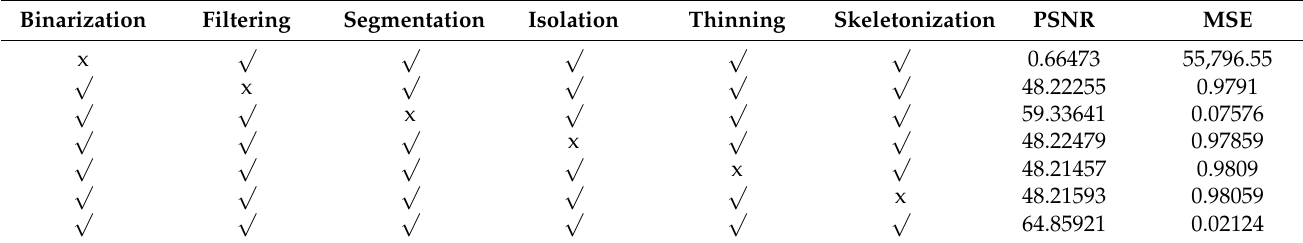
Table 2. Results of preprocessing on the SID database.